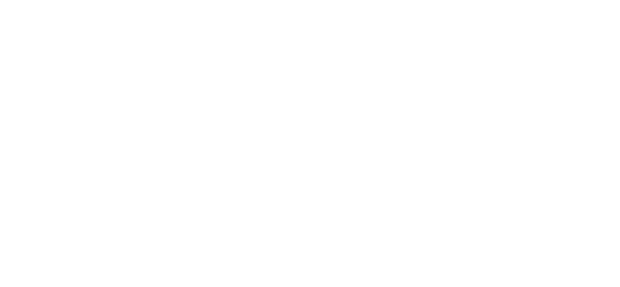
Table 2. Addition of TiO 2 nanoparticles.